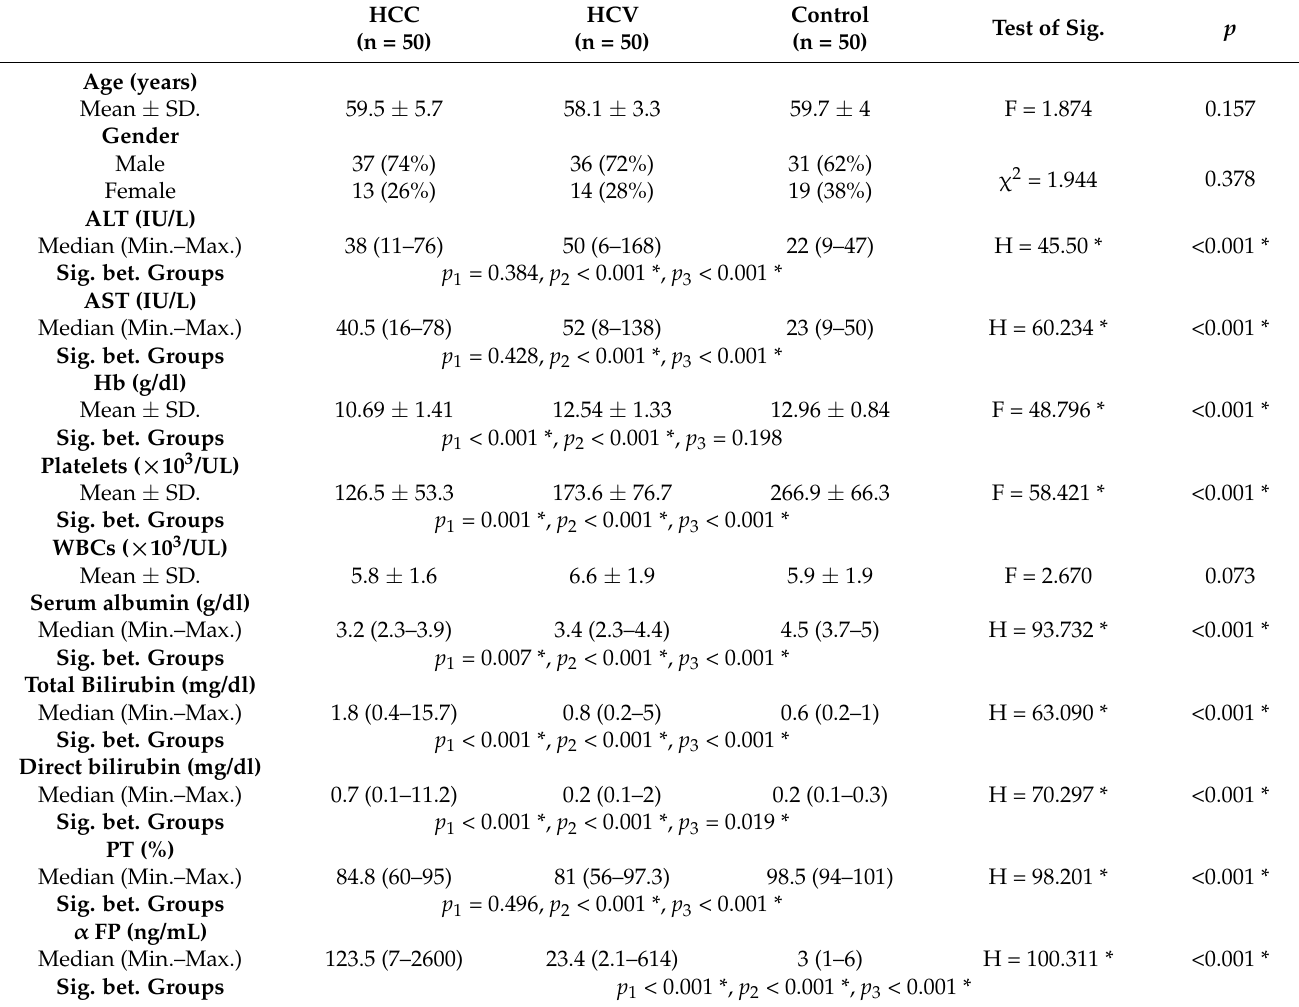
Table 1. Demographic and laboratory data in the three studied